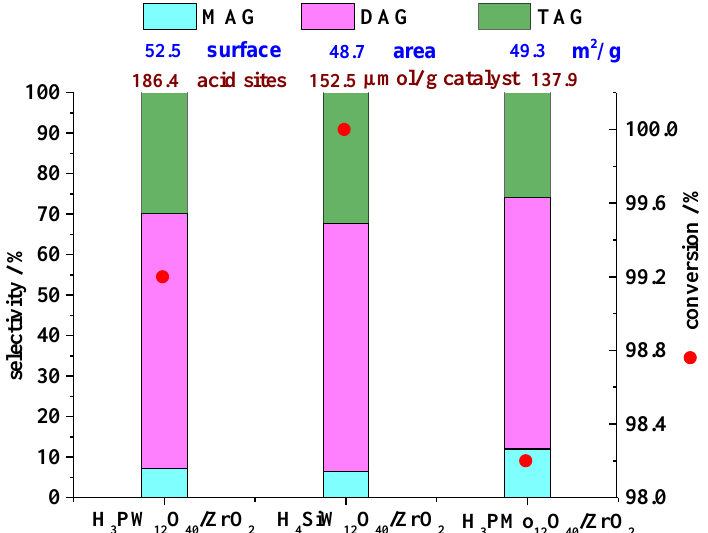
Figure 2. Catalytic performance of glycerol esterification with acetic acid over different HPA/ZrO 2 catalysts (adapted from ref. [45]). Reaction conditions: reaction temperature (393 K); the molar ratio of glycerol to acetic acid (1:10); catalyst amount (0.3 g).